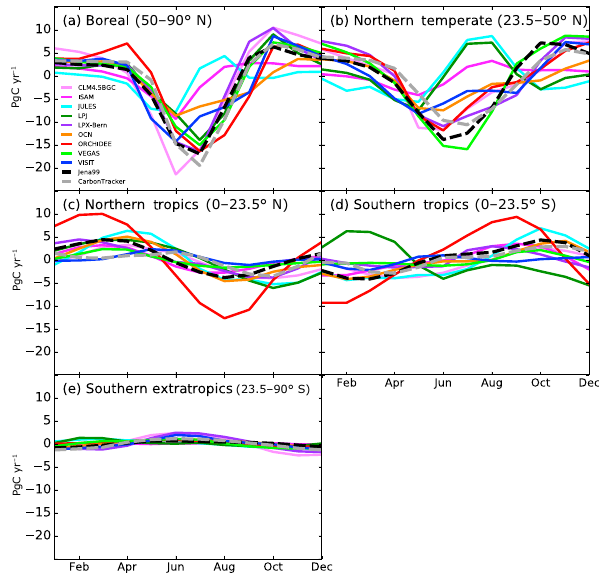
Figure 2. Mean seasonal cycle of net carbon flux totals over bo- real (50–90 ◦ N), northern temperate (23.5–50 ◦ N), northern tropics (0–23.5 ◦ N), southern tropics (0–23.5 ◦ S) and southern extratrop- ics (23.5–90 ◦ S) from nine TRENDY models and two inversions, Jena99 and CarbonTracker, averaged over